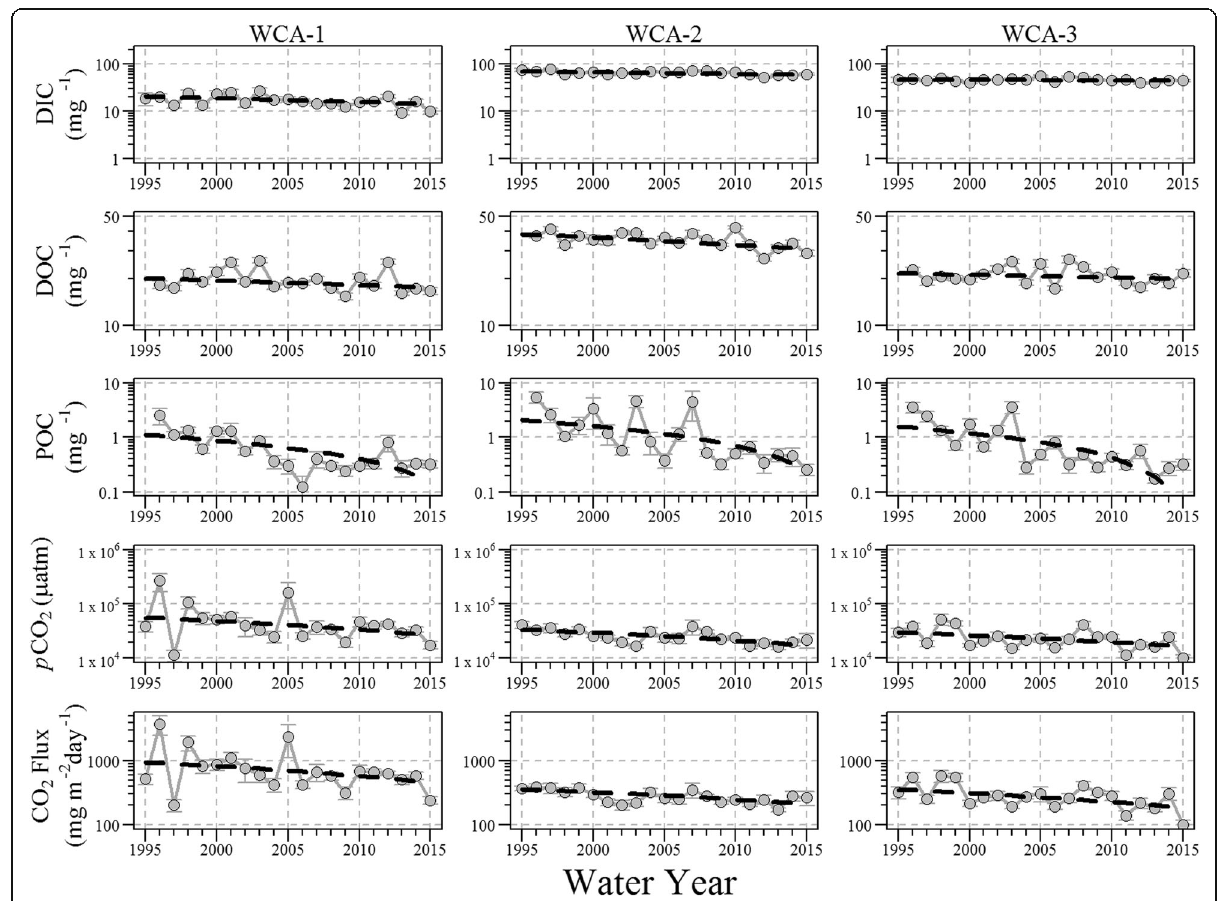
Fig. 3 Annual mean dissolved inorganic carbon concentrations, dissolved organic carbon, particulate organic carbon, and surface water pCO 2(aq) for interior portions of the Everglades Protection Area between water years 1995 and 2015 (May 1, 1994 – April 30, (Table 2). Mean monthly POC concentrations were only correlated with monthly mean TP and specific conductiv- ity for WCA-2 and WCA-3 (Table 4).